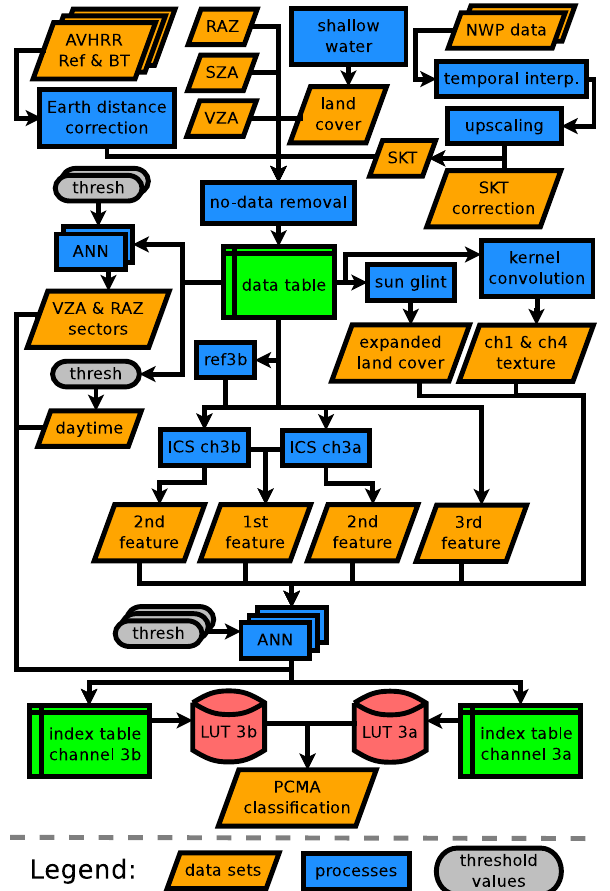
Fig. 3. Flow chart of the PCM algorithm. For details see Sect. 3.5.